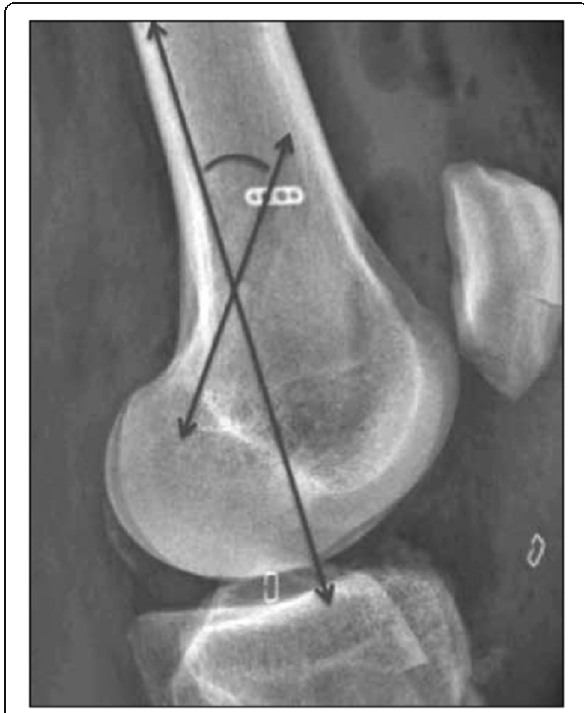
Fig. 3 Measurement of femoral tunnel anteversion on true lateral postoperative radiographs. Anteversion is the angle between the posterior cortex of the femoral diaphysis and the line running long the middle of the femoral tunnel ending at the endobutton